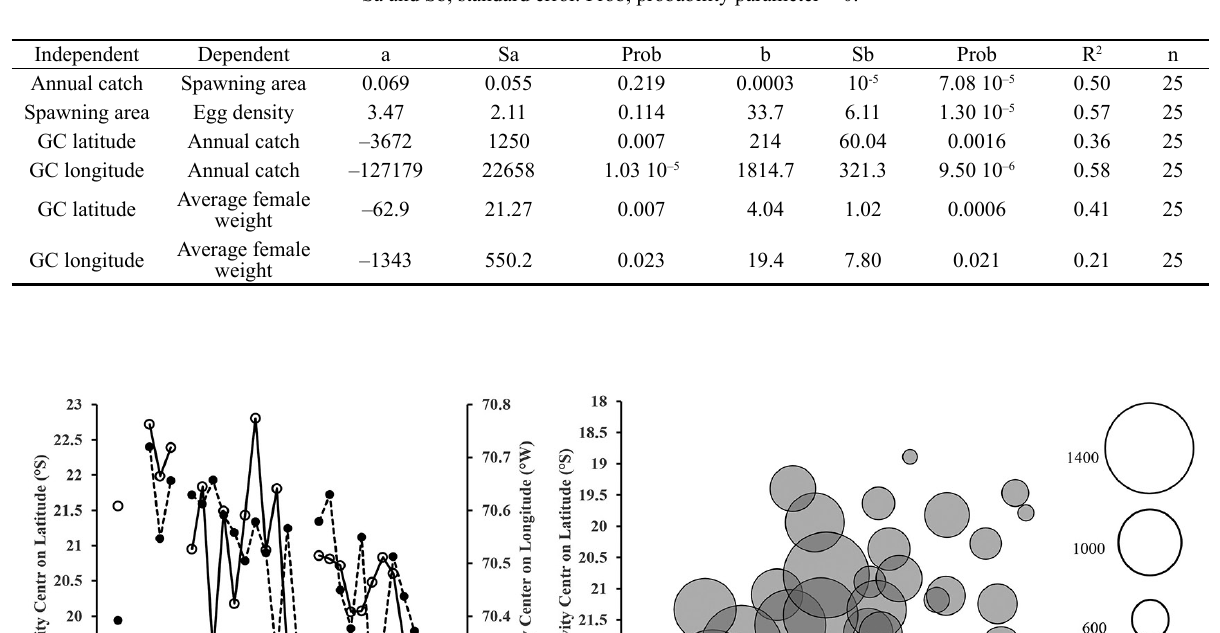
Table 2. – Results of the linear regressions between independent (X) and dependent (Y) variables. CG, Gravity Centre; a, Intercept; b, slope; Sa and Sb, standard error. Prob, probability parameter = 0.